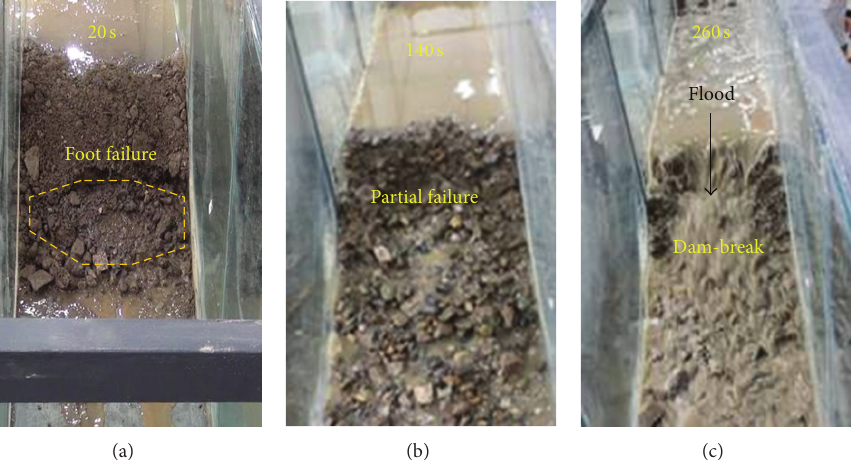
Figure 14: Process of dam break of a landslide dam without any discharge channel at different time intervals: (a) 20s, (b) 140 s, and (c)